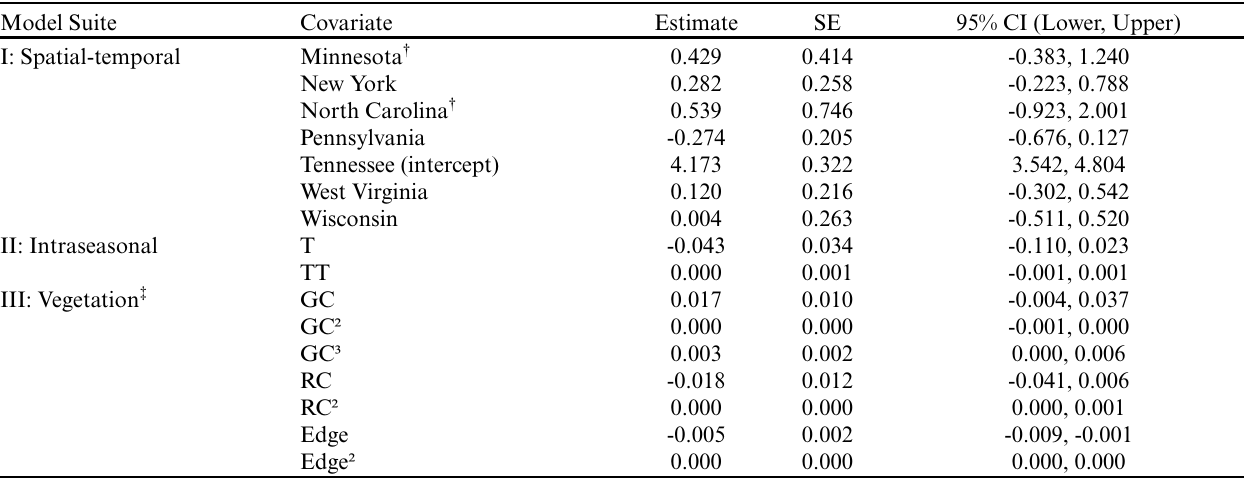
Table 4 . Model-averaged (across models containing the covariate) coefficients for covariates in best-supported ( Δ QAICc < 2) models of daily survival rate of Golden-winged Warbler ( Vermivora chrysoptera ) nests from Models Suites I, II, and III on sites located in Minnesota, Wisconsin, New York, Pennsylvania, West Virginia, North Carolina, and Tennessee, 2008-2012. See Table 1 for the full list of models and their notation.